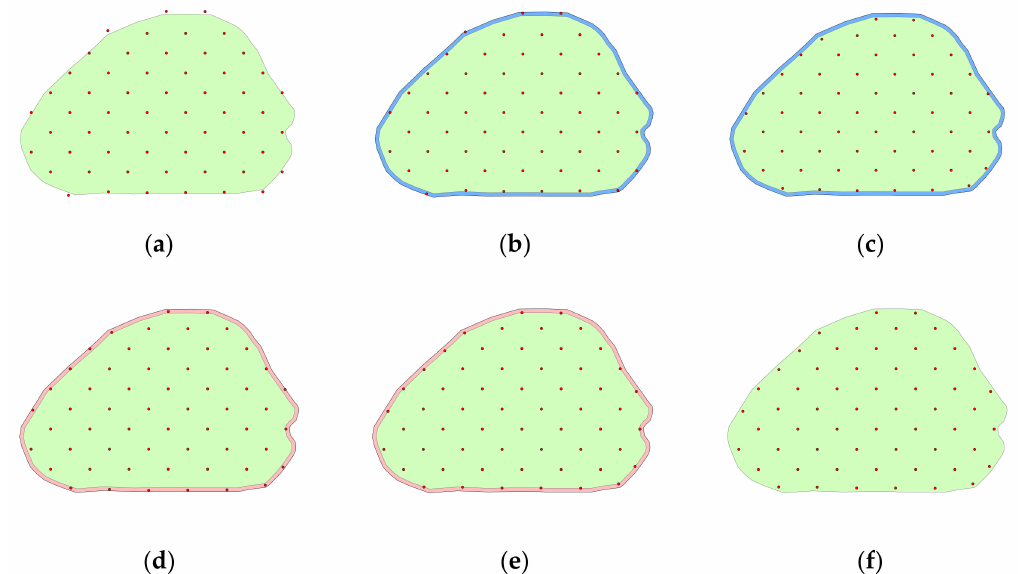
Figure 8. Filling under the constraint of boundary features. ( a ) Initial three-square shaped filling. ( b ) Outer buffer constraint. ( c ) Processing result of the outer buffer constraint. ( d ) Inner buffer constraint. ( e ) Processing result of the inner buffer constraint. ( f ) Filling result after the boundary constraint has been